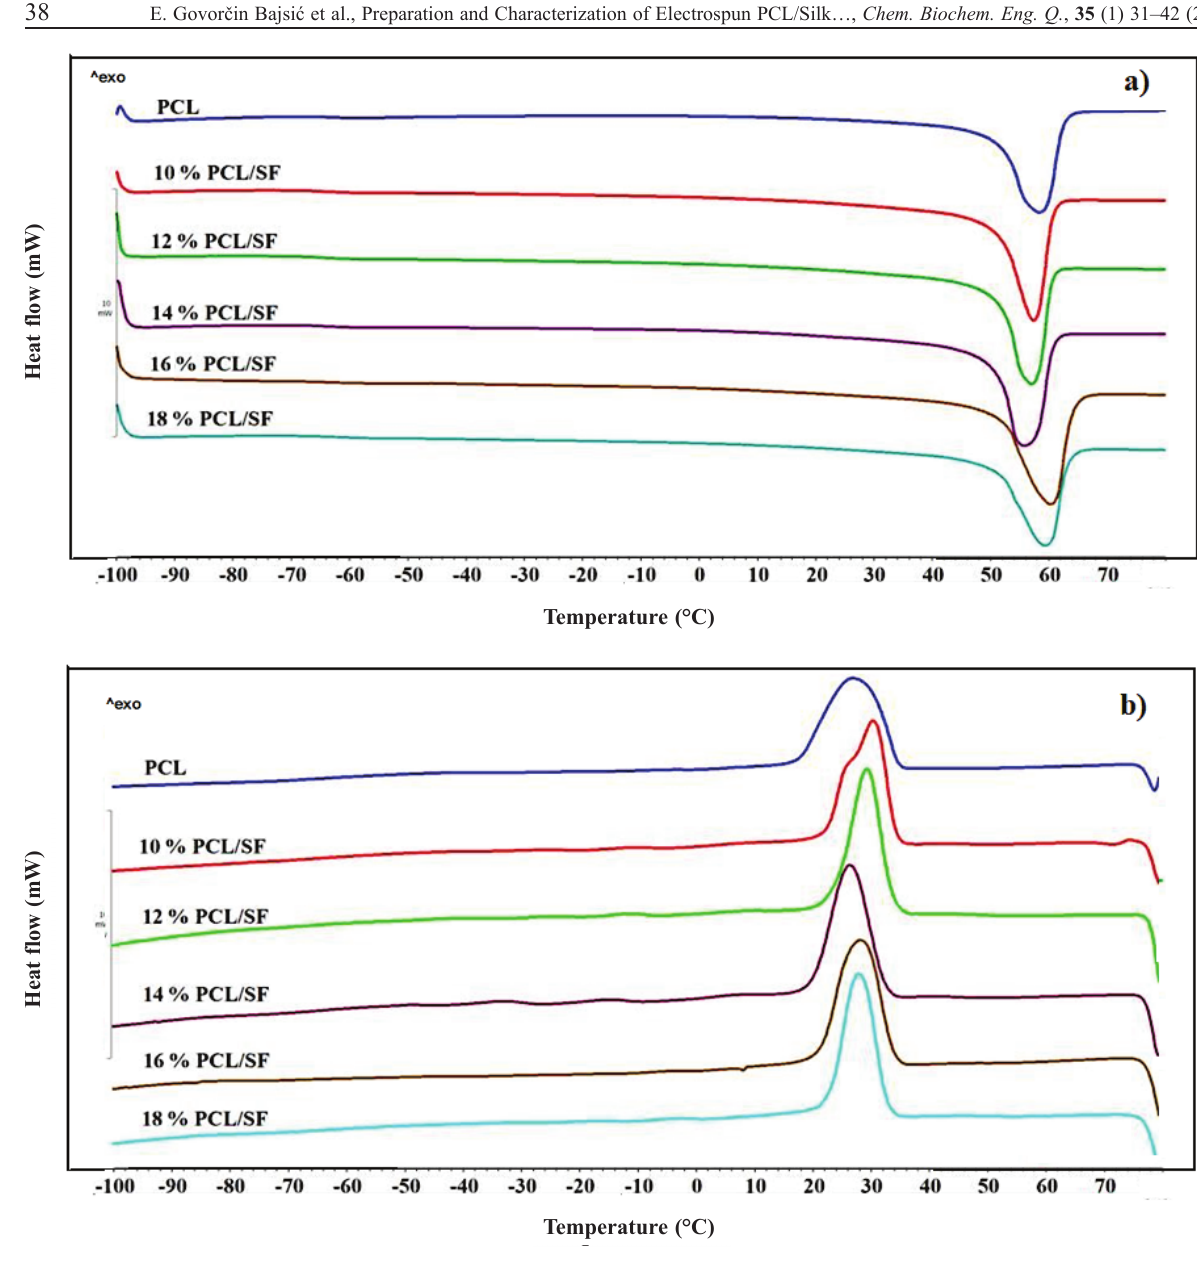
Fig. 5 – DSC curves of the electrospun PCL and PCL/SF scaffolds during second (a) heating, and (b) cooling